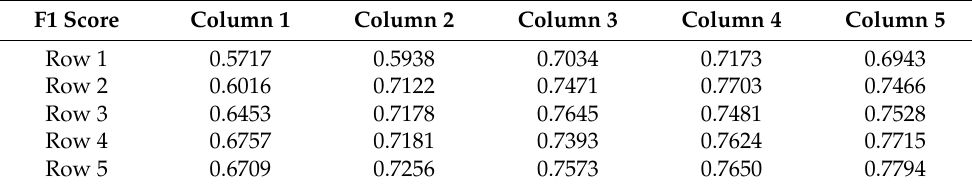
Figure 6. Average F1 score of different parts and line widths. Table 4. Average F1 score of different parts (in Figure 3) with all line